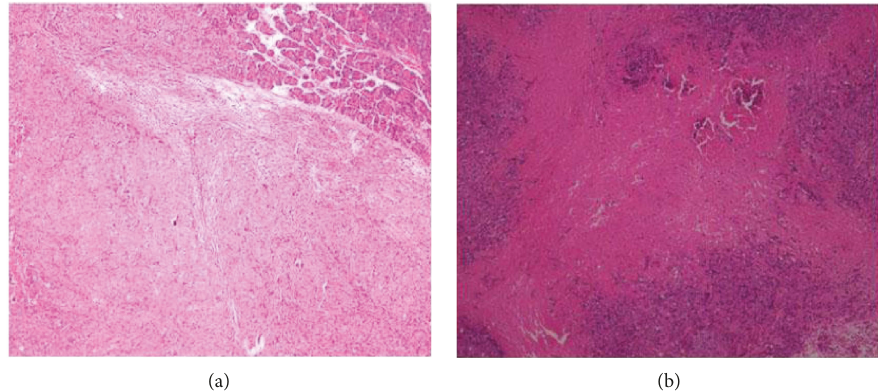
Figure 5: Histology of the orthotopic pancreatic cancer cell mouse xenograft model after ethanol injection. On day 7, all mice were sacri fi ced and the tumor xenografts were resected for tissue processing and H&E staining. (a) Saline injection. (b) 80% ethanol injection. Severe coagulation and necrosis occurred in the tumor xenografts after the 80% ethanol